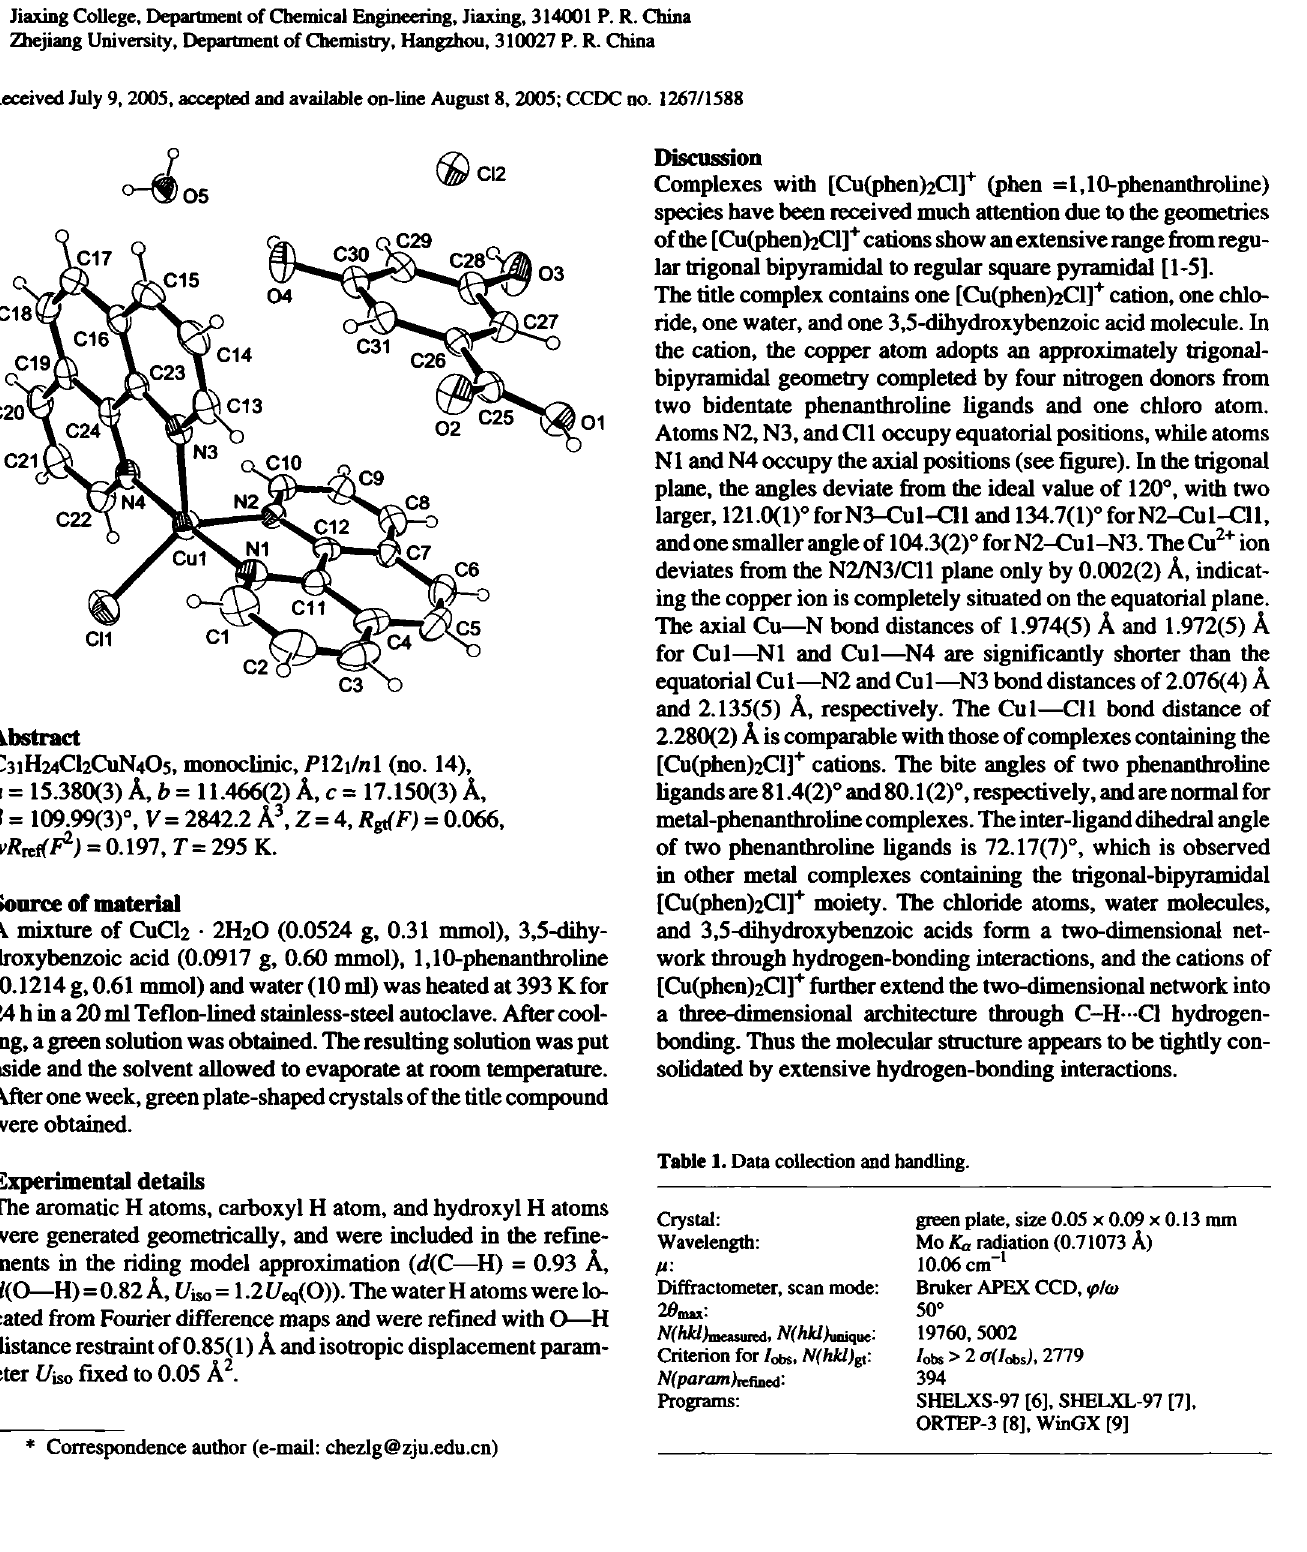
Table 1. Data collection and